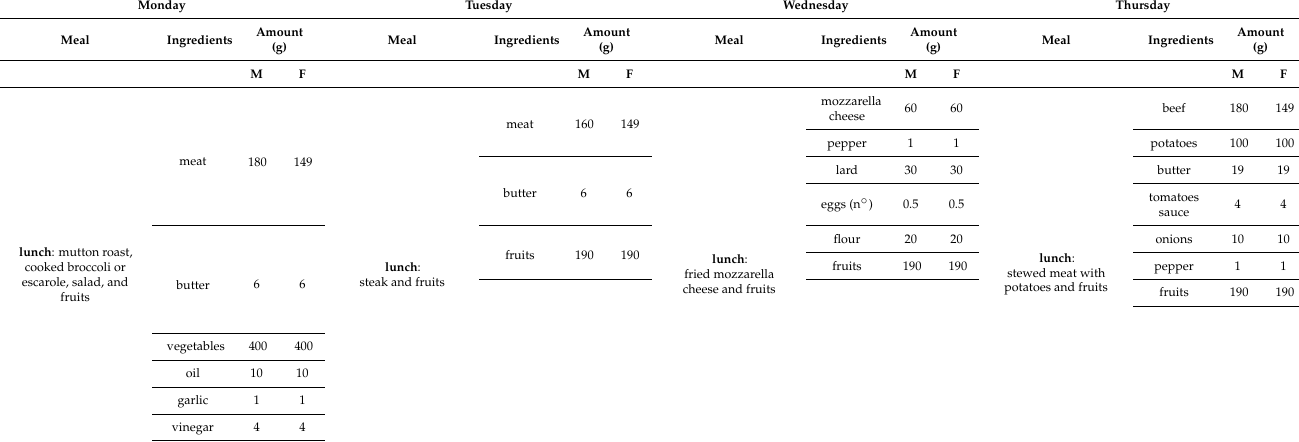
Table 5. Individual meals for 1st and 2nd class patients at lunch and dinner. Months: March, April and May (1)